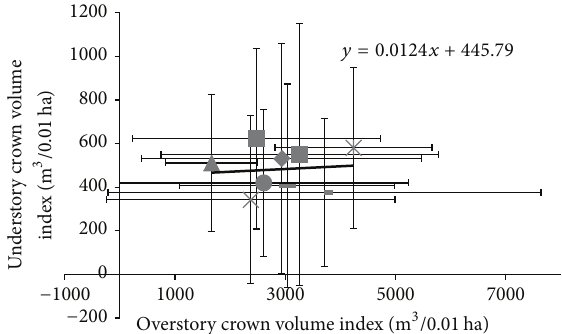
Figure 5: Linear regression relationship between overstory and understory crown volume index (m 3 /0.01 ha) ( P = 0.91, 𝑟 = 0.04, means ± 95%